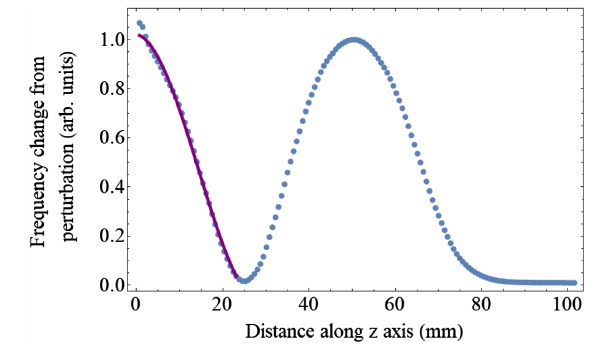
FIG. 18. Field flatness in the 400 Hz photoinjector after brazing. Blue dots represent the measurement; the red line is a fit that removes the effect of image charges of the bead on the